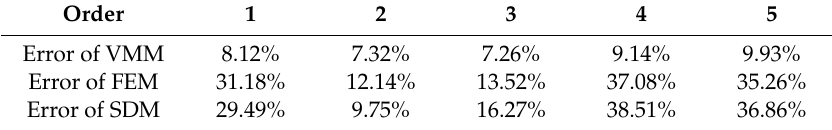
Table 3. Errors of the first five natural frequencies obtained by simulation and experiment.